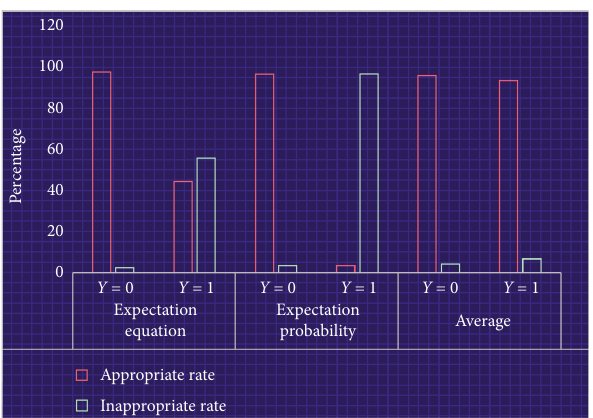
Figure 4: Forecast-expectation analysis of early warning indicators of static